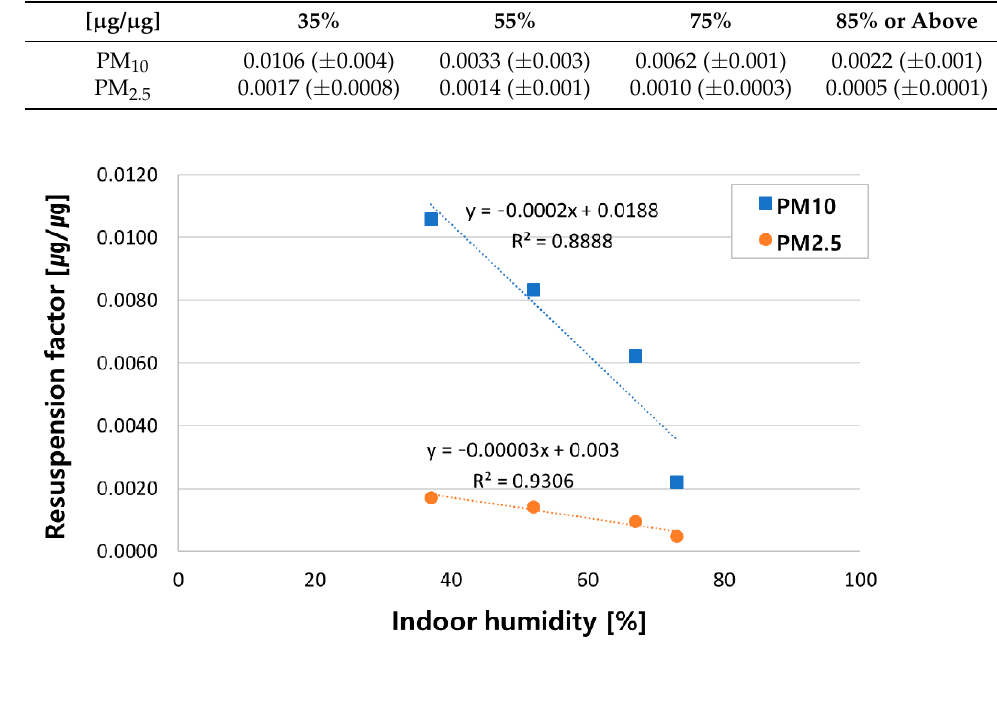
Table 7. PM resuspension factors of the classroom chamber under each humidity condition.